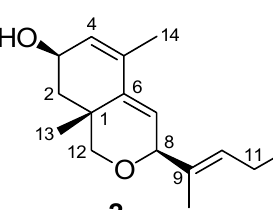
Figure 3. Apocarotenoid 2